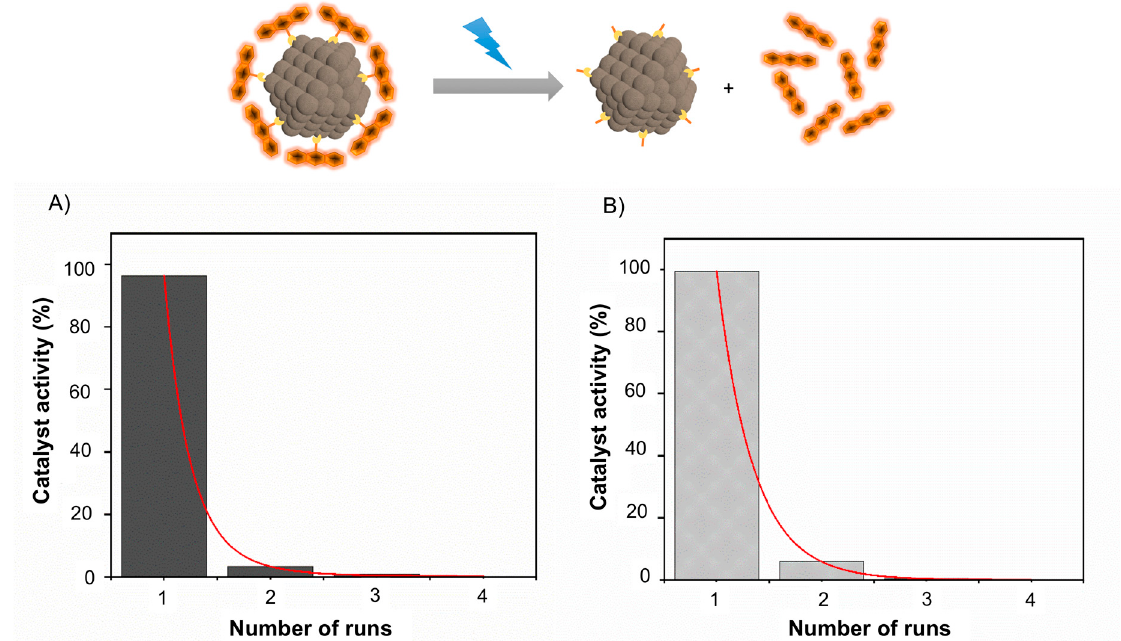
Figure 6. The recyclability of IONP-DAFL over four runs of AMT photodegradation with (A) MES in O 2 and with (B) EDTA as an electron donor in Ar. The catalyst’s activity is calculated from the concentration of remaining AMT in solution (C/C 0 ) measured using UV-vis absorption spectroscopy ( λ max = 520 nm) after irradiation with 450 nm blue light for 1 h per run. The images show the flavin molecules separated from the nanoparticle surfaces due to photodegradation.